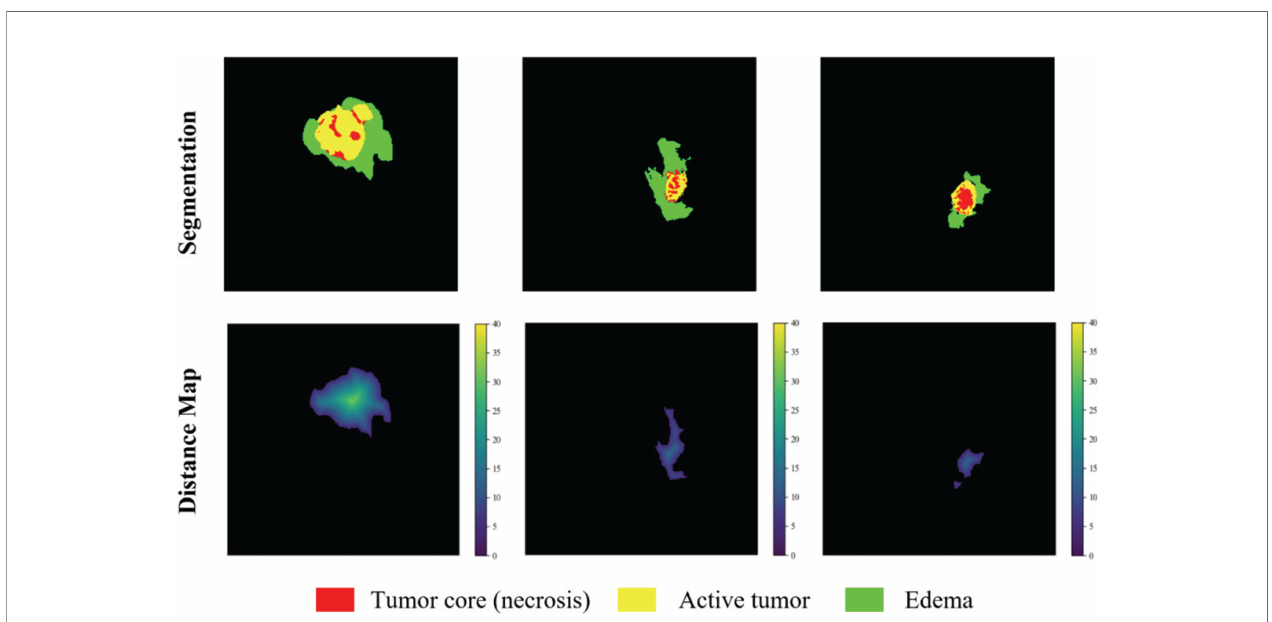
FIGURE 3 | The example output results of the two decoders. Red color represents the tumor core (necrosis), yellow color represents the active tumor and green regions are the